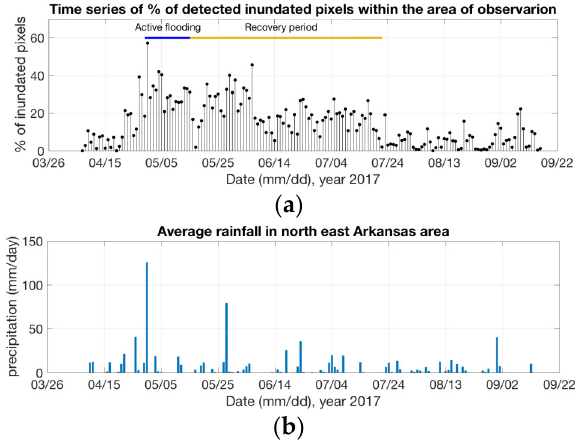
Figure 14. Flooding monitoring plots. ( a ) Percentage of flooded pixels normalized to the number of measured pixels for the area under study during a period covering April to August 2017. The black stem lines are actual measurements, the blue line corresponds to active flooding period, and the orange line corresponds to recovery period. ( b ) Averaged daily rainfall in NE Arkansas area under study obtained from [60].